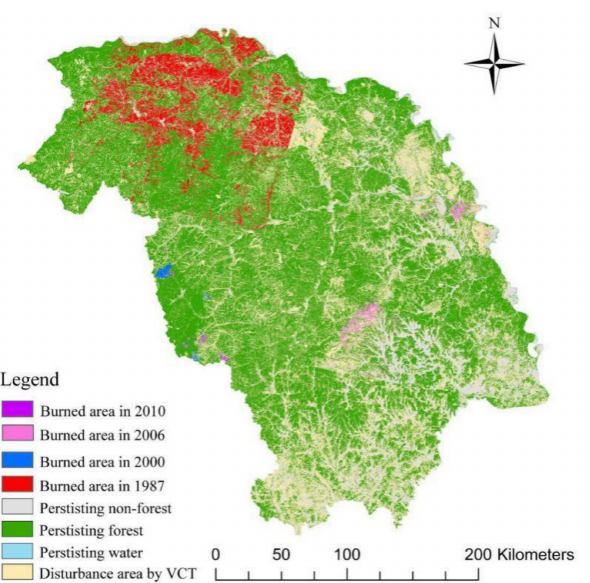
Figure 4. Disturbance area obtained from VCT, persisting land cover types, and burned areas in the study region derived from the VCT-SVM